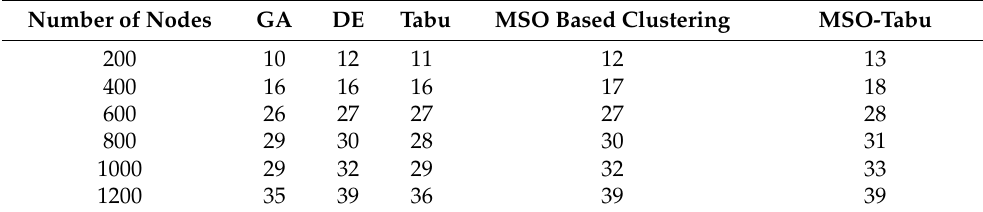
Table 2. Number of clusters formed for MSO-Tabu.